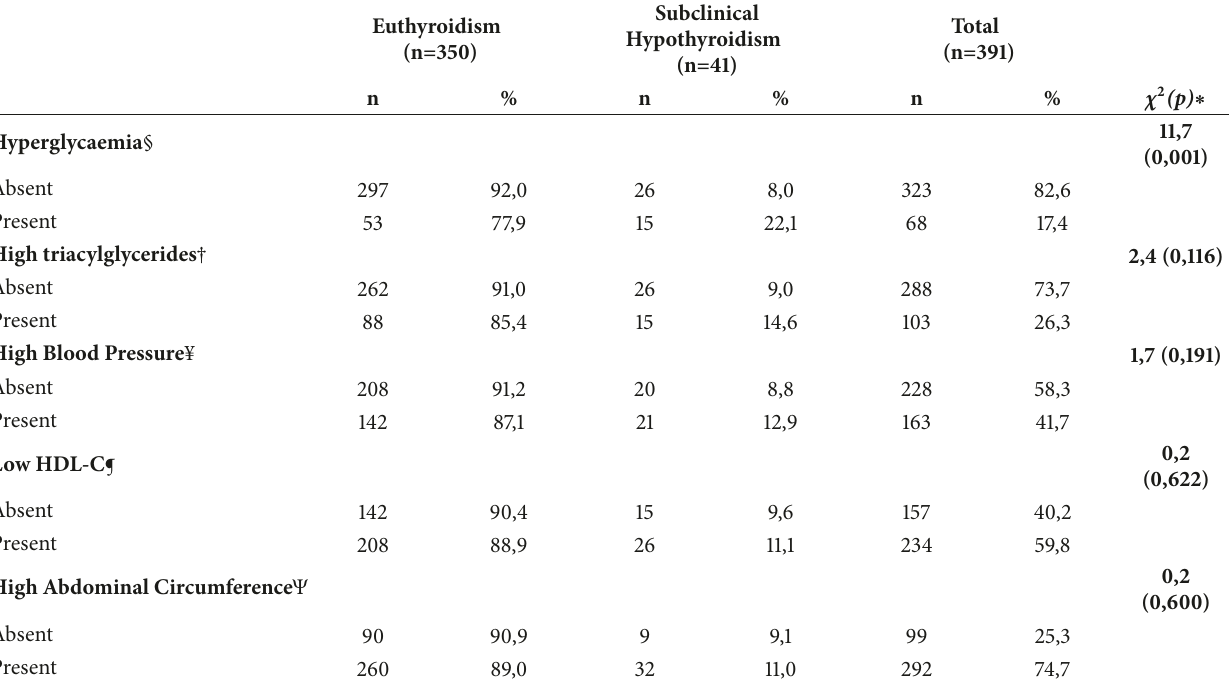
Table 2: Subclinical hypothyroidism and components of metabolic syndrome in adults from Maracaibo City,